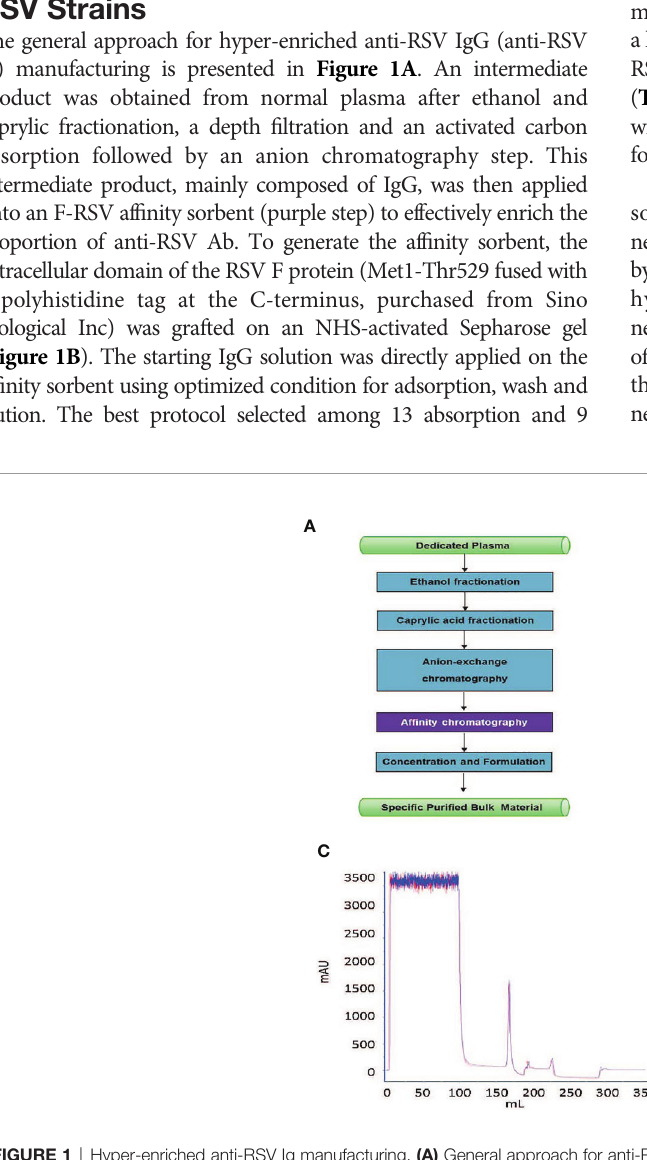
FIGURE 1 | Hyper-enriched anti-RSV Ig manufacturing. (A) General approach for anti-RSV Ig manufacturing. (B) Principle of the af fi nity step. (C) Hyper-enriched anti-RSV Ig af fi nity step chromatogram. This fi gure illustrates the reproducibility of the af fi nity step with the chromatogram superposition of two independent batches. (D) The integrity of the hyper-enriched anti-RSV Ig was compared to a commercial normal polyclonal IgG (ClariYg ® ) by Coomassie blue staining